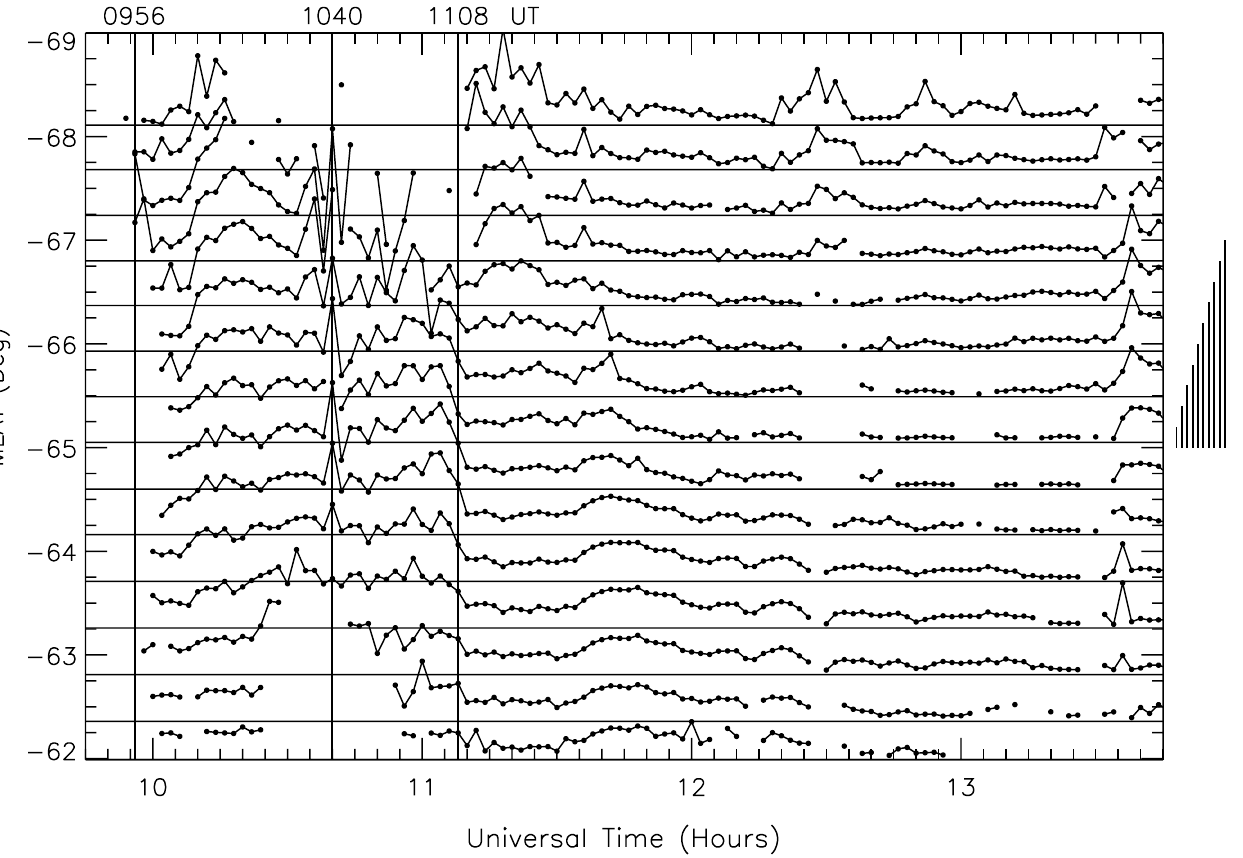
Fig. 5. Stack plot of flow speeds estimated along TIGER beam 4 using the beam-swinging technique at 2-min time resolution during 09:45 to 13:45UT on 27 February 2000. The flow speeds were calculated at intervals of just under 0.5 ◦ 3 , and the scale used was 1kms − 1 per 1 ◦ 3 . The ascending scale at right shows speeds of 200, 400,..., 2000ms − 1